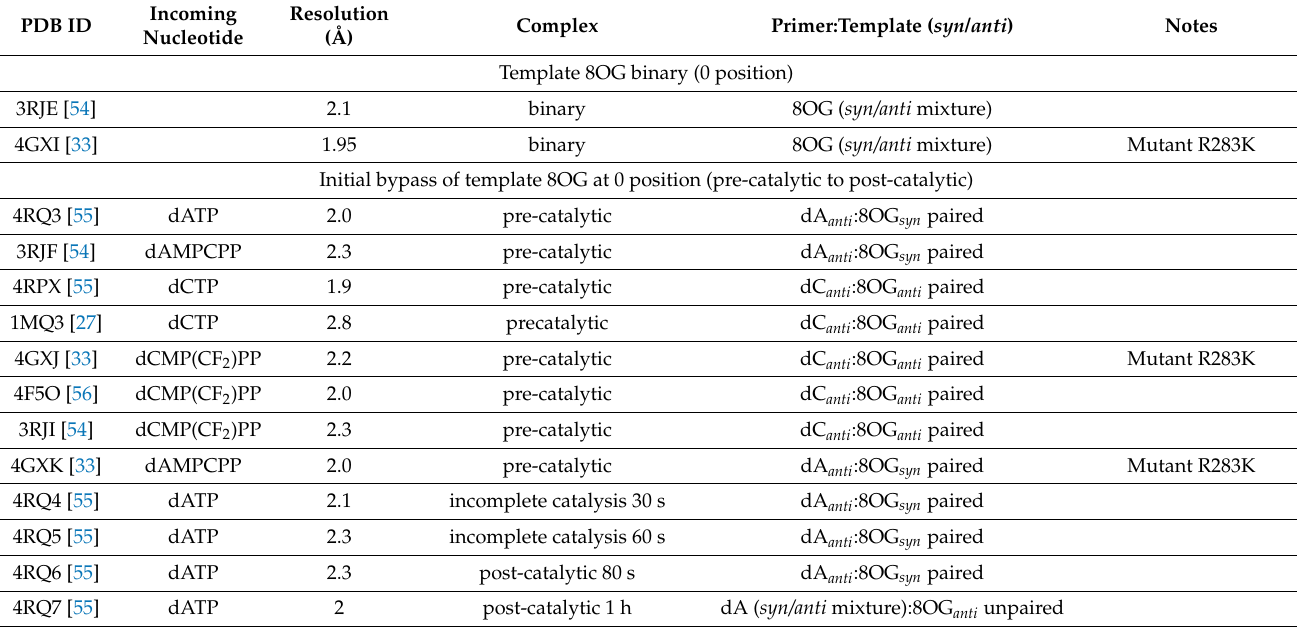
Table 1. X-ray crystal structures of template 8OG bypass and extension by Pol β